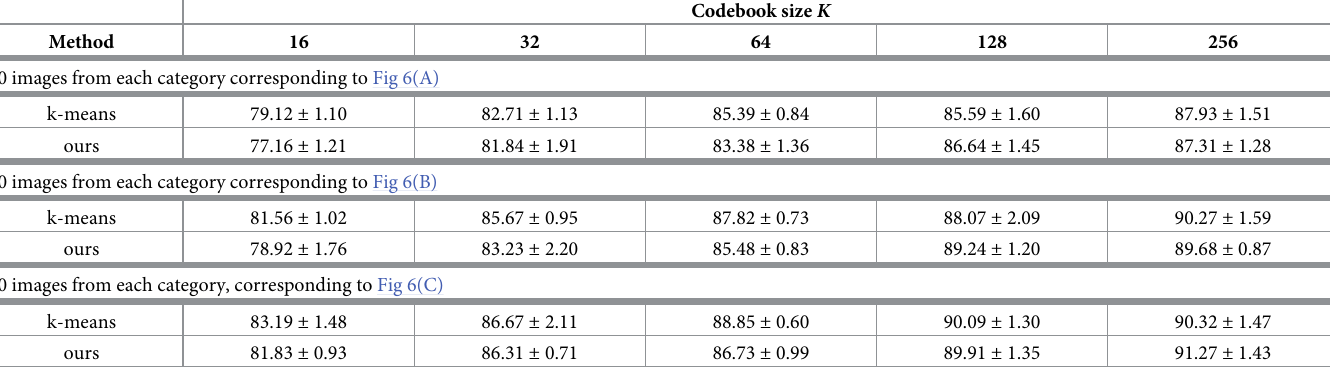
Table 8. Recognition performance (mean accuracy ± standard deviation) of the VLADs with the k-means and ours (hard objective) codebooks on the Butterflies, corresponding to the Fig 6.